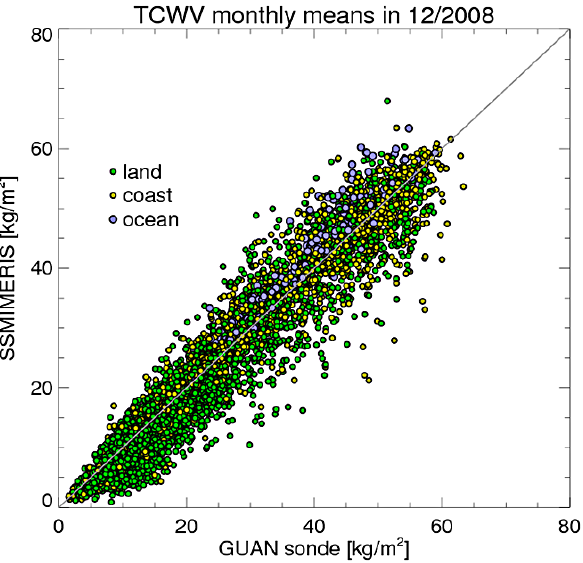
Figure 6. Scatterplot of SSM/I–MERIS monthly mean TCWV vs. individual GUAN stations for the period 2003–2009 (5492 collocated cases, with 67% land, 29% coast and 4% ocean cases). Resulting root-mean-square deviation is 4.4kgm − 2 , bias is 0.7kgm − 2